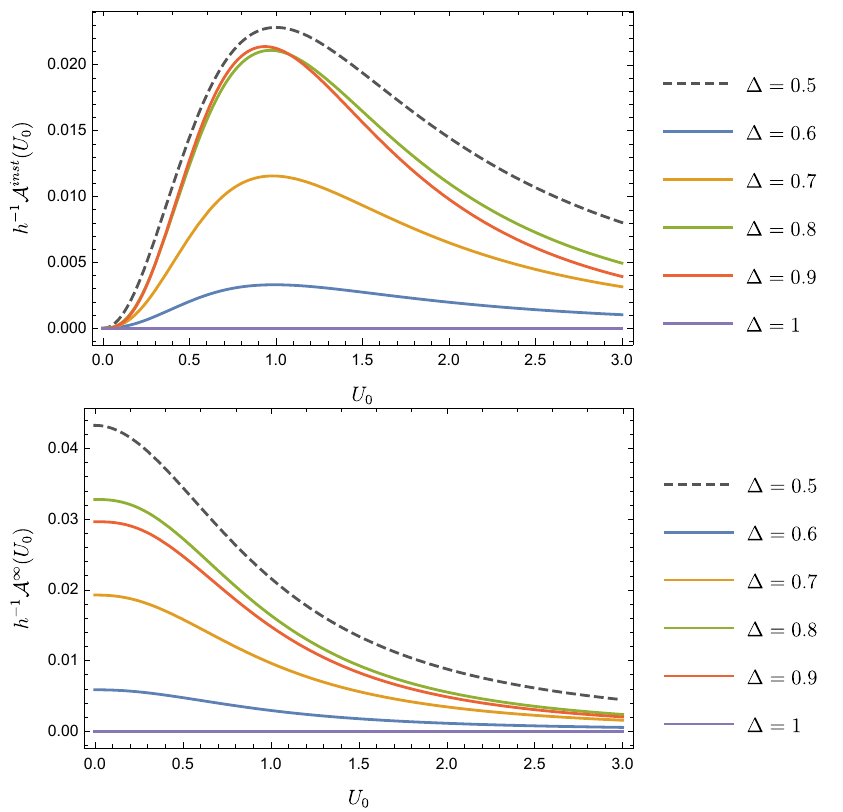
Figure 4 . The ANE as a function of U 0 for non-zero qe 2 = 0 . 1